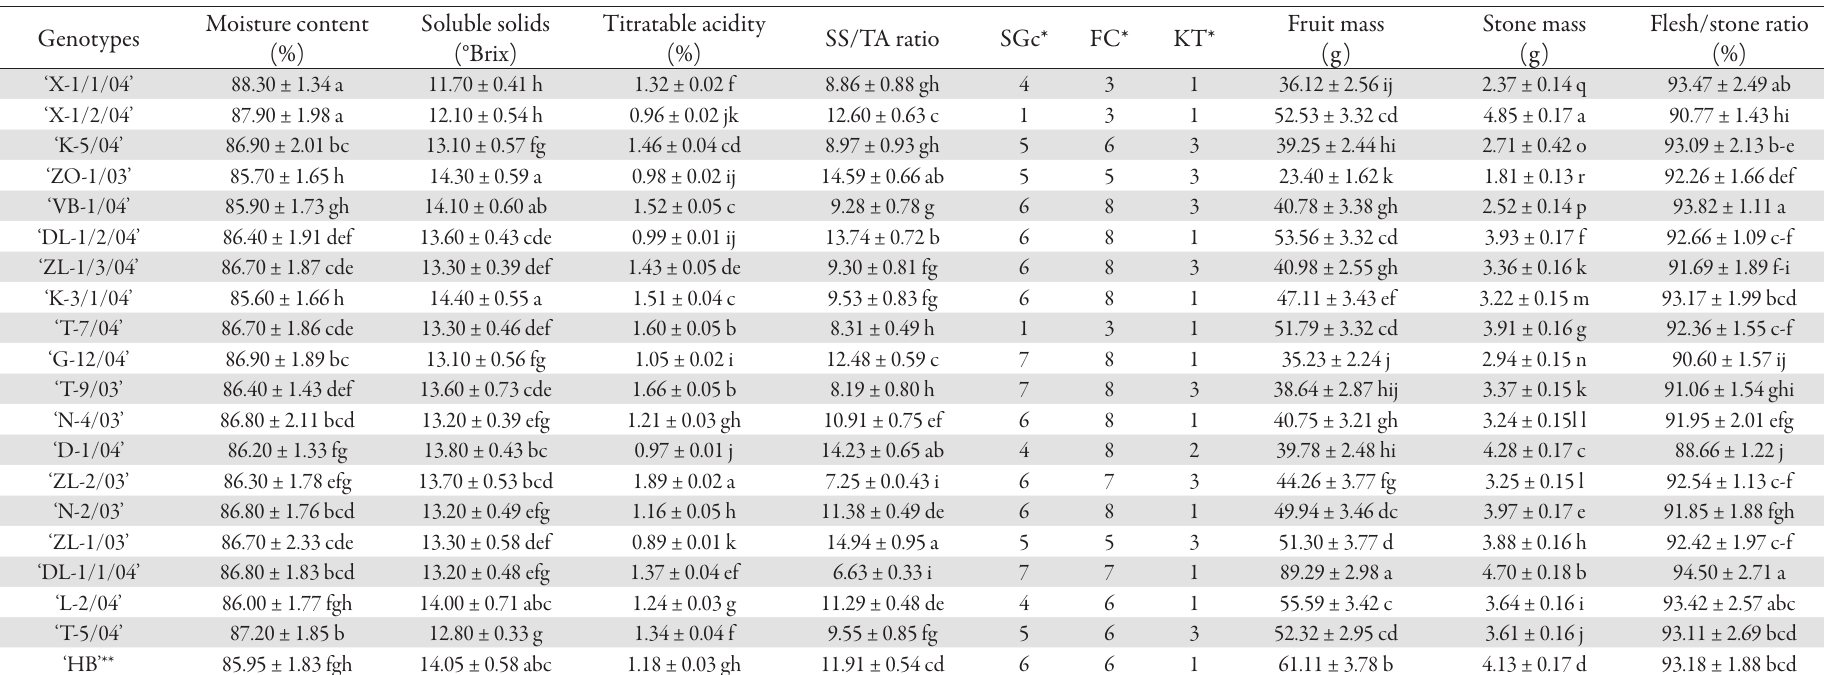
Tab. 1. Chemical, sensorial and some physical-mechanical properties of 19 apricot genotypes and control